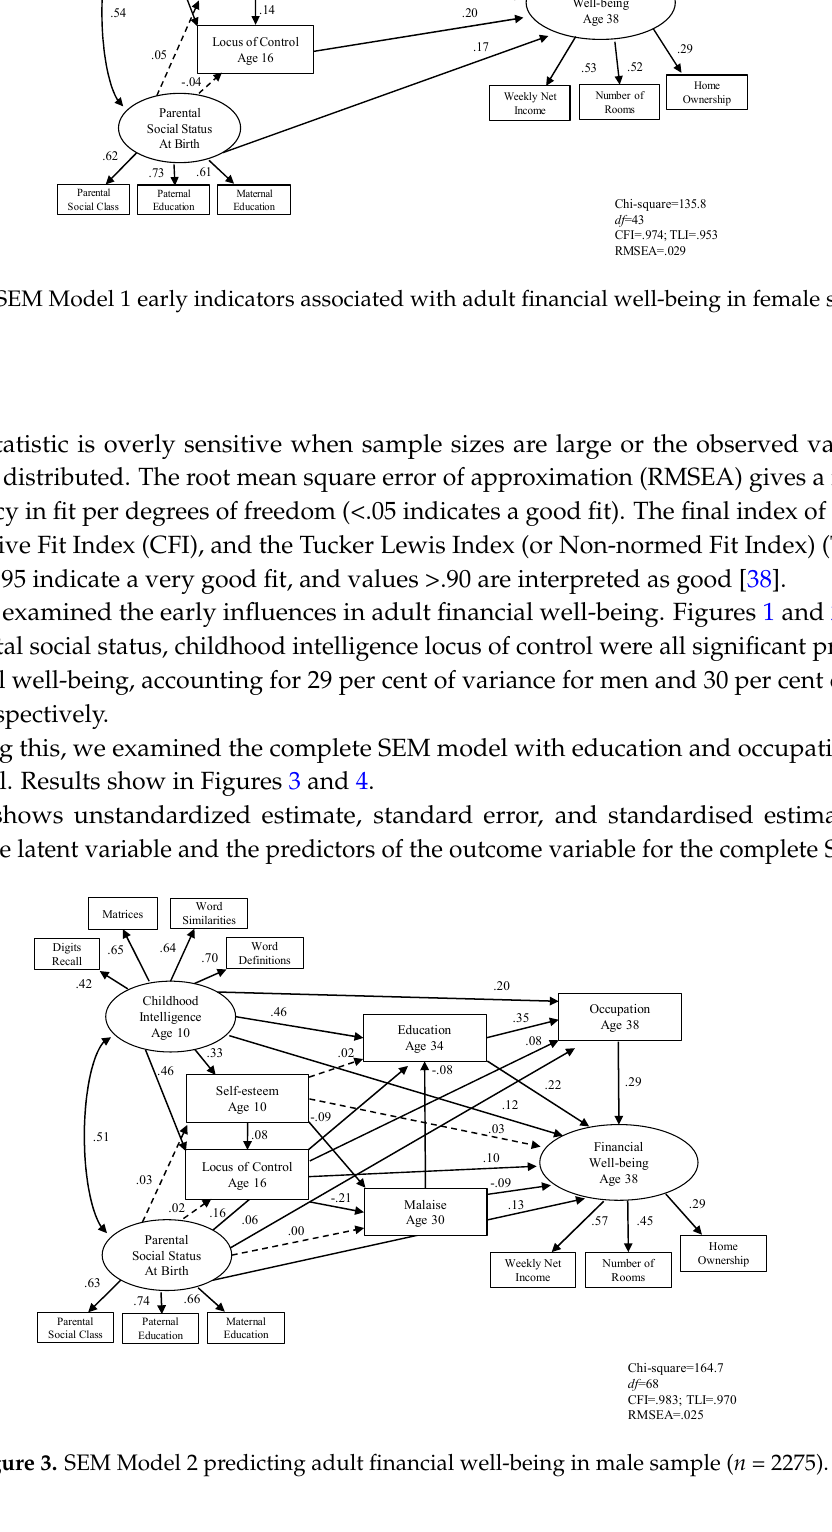
Figure 3. SEM Model 2 predicting adult financial well-being in male sample ( n = 2275).